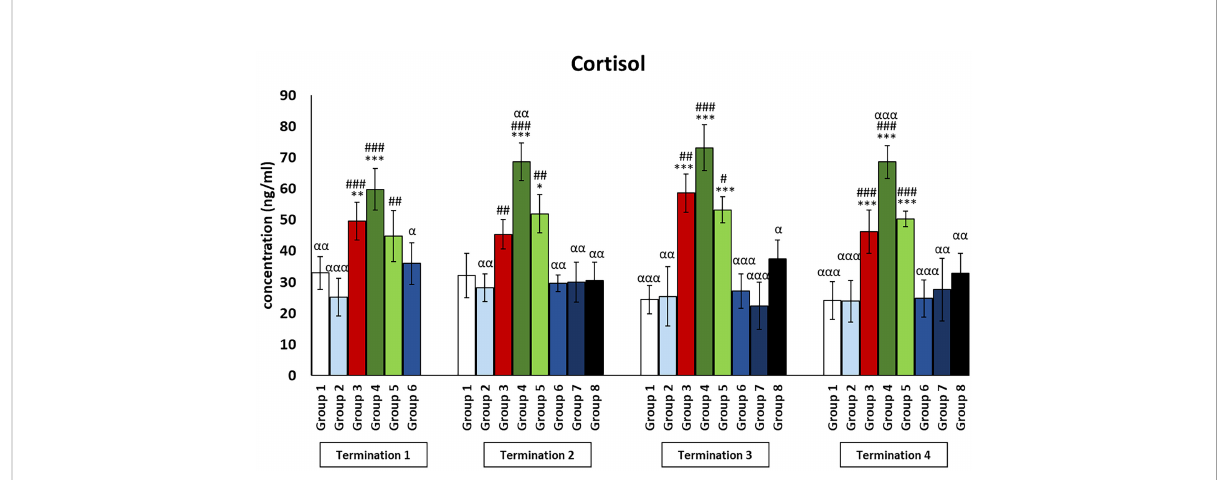
FIGURE 9 Changes in the levels of cortisol in the blood of chickens receiving phage therapy or antibiotic therapy after 6, 20, 28, and 34 days of experiments. Results are presented as mean values ± SD. Statistical analyses were performed by Kruskal – Wallis test and post-hoc Dunn test or ANOVA and post-hoc Tukey ’ s test. The signi fi cance of differences between controls and particular treated groups is observed and marked by the following: asterisks (*) vs. saline control; (#) vs. phage control (group 2); (a) vs. infected control (group 3); (g) vs. termination 2. p < 0.001 (***, ###, aaa ), p < 0.01 (**, ##, aa ), and p < 0.05 (*, #, a ).